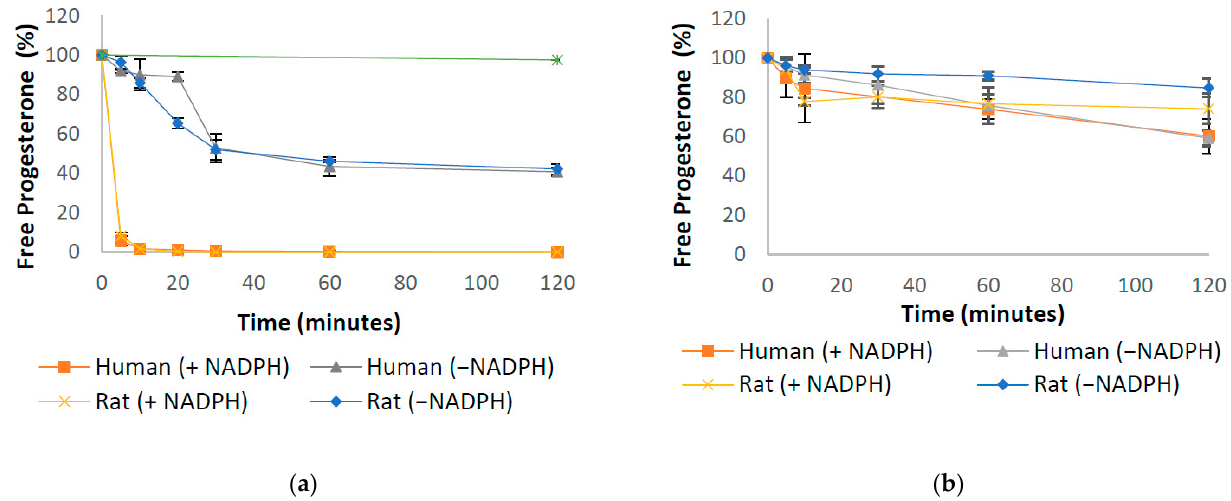
Figure 2. Stability profile of progesterone in human and rat liver ( a ) and intestinal ( b ) homogenates in the presence and absence of NADPH ( n = 3, error bars are +/ − SD).